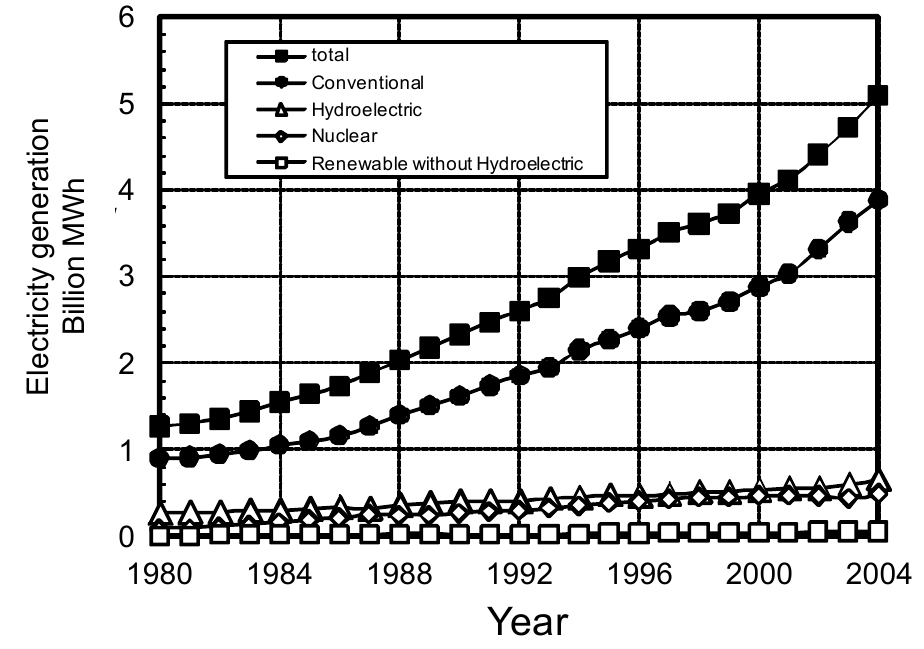
Figure 3. Time-line of electricity generation with respect to generation method in Asia and